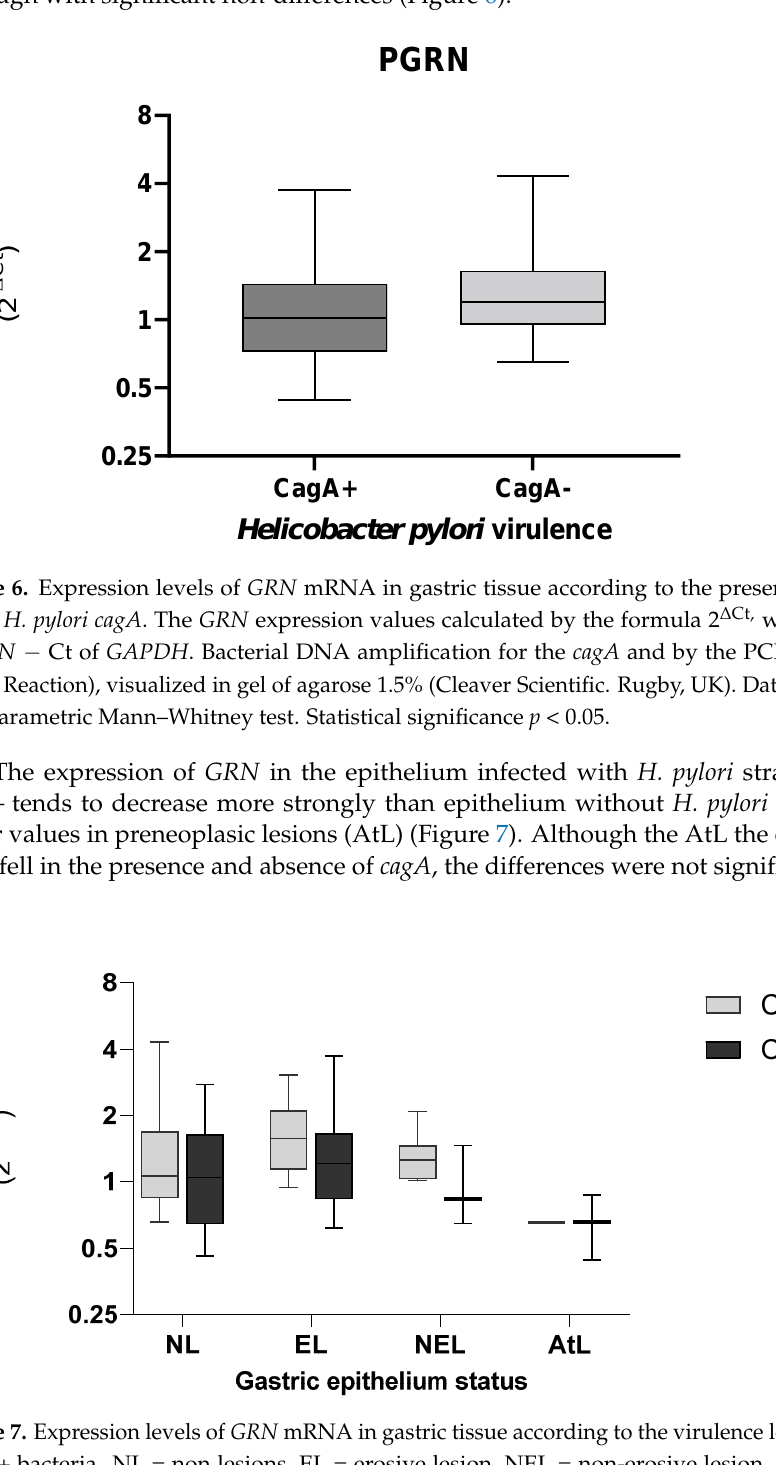
both groups ( p = 0.030), and in only the NL epithelium ( p = 0.043) (Figure 8B). Regarding the vacA s2m2 + alleles, we did not observe important differences when comparing the lev- els of GRN in tissues colonized by strains that express, or do not express, this allele. When observing the tissue status of s2m2 + strains, the GRN remains equally expressed in erosive epithelia (EL) and non-erosive epithelia (NEL). Furthermore, the GRN expressions were even higher than those expressed in NL tissues, although they were non-significant.